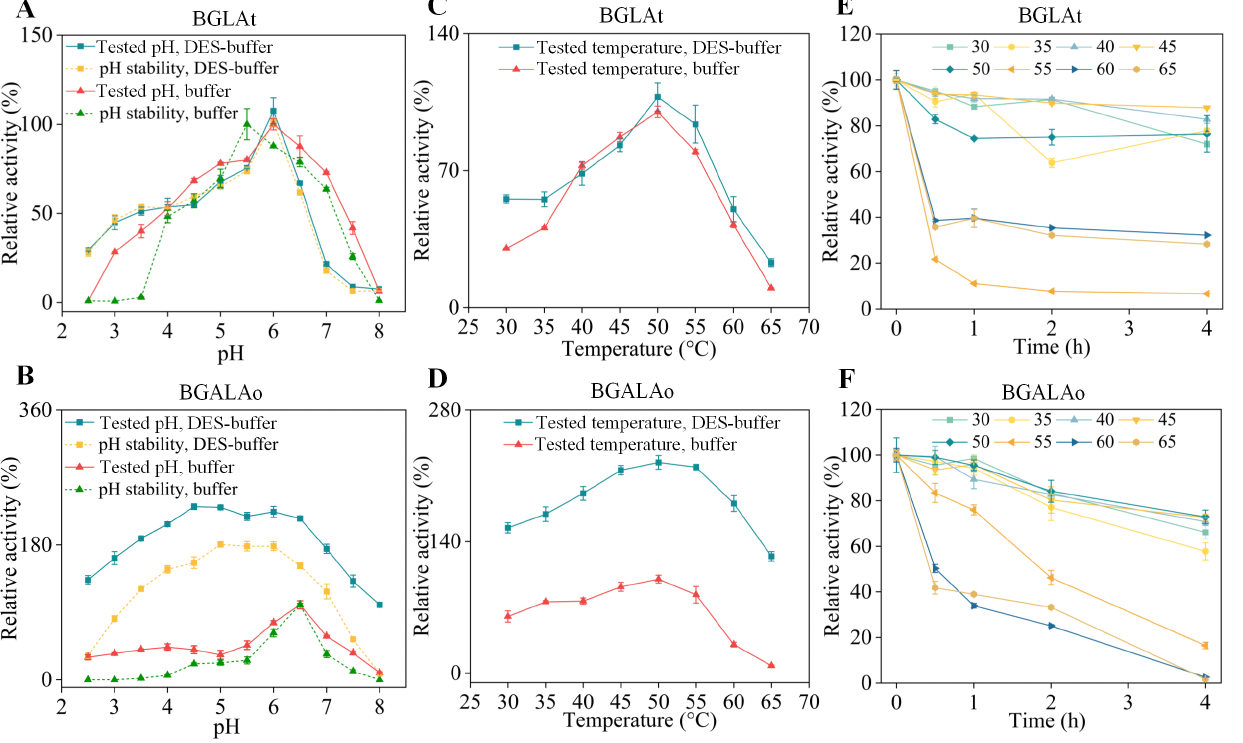
Figure 2. Effects of pH and temperature on the activity and stability of the combinatorial enzymes (BGLAt and BGALAo) incubated in the DES-buffer. ( A ) Study of the optimal pH (50 °C) and pH stability (50 °C, 1 h) of BGLAt incubated in the DES-buffer or buffer. ( B ) Study of the optimal pH (50 °C) and pH stability (50 °C, 1 h) of BGALAo incubated in the DES-buffer or buffer. ( C ) Study of the optimal temperature of BGLAt incubated in the DES-buffer or buffer. ( D ) Study of the optimal temperature of BGALAo incubated in the DES-buffer or buffer. The state (incubate in buffer) with the highest enzyme activity was defined as 100% ( A – D ). ( E ) Thermostability of BGLAt incubated in the DES-buffer or buffer. ( F ) Thermostability of BGALAo incubated in the DES-buffer or buffer. The activity without pre-incubation was defined as 100% ( E , F ). DES-buffer means that the buffer (citric acid buffer, 20 mM, pH 6.0) contains 10 wt % of DES (Bet: EG, 1:2) ( A – F ). Error bars represent the corresponding standard deviation of three independent experiments ( n =